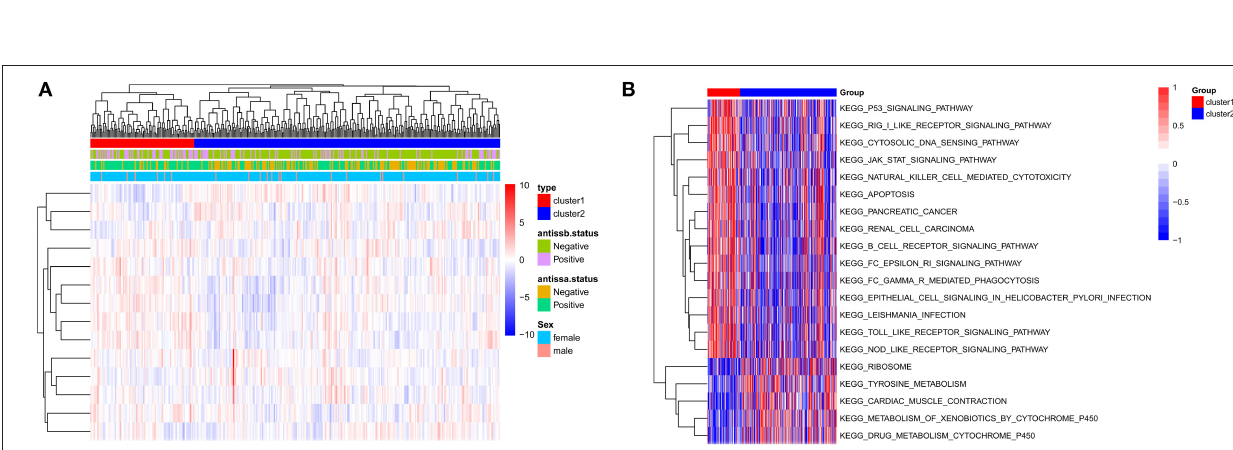
subtypes were enriched in 50 KEGG pathways. The 14 feature genes were finally verified using GEO datasets and